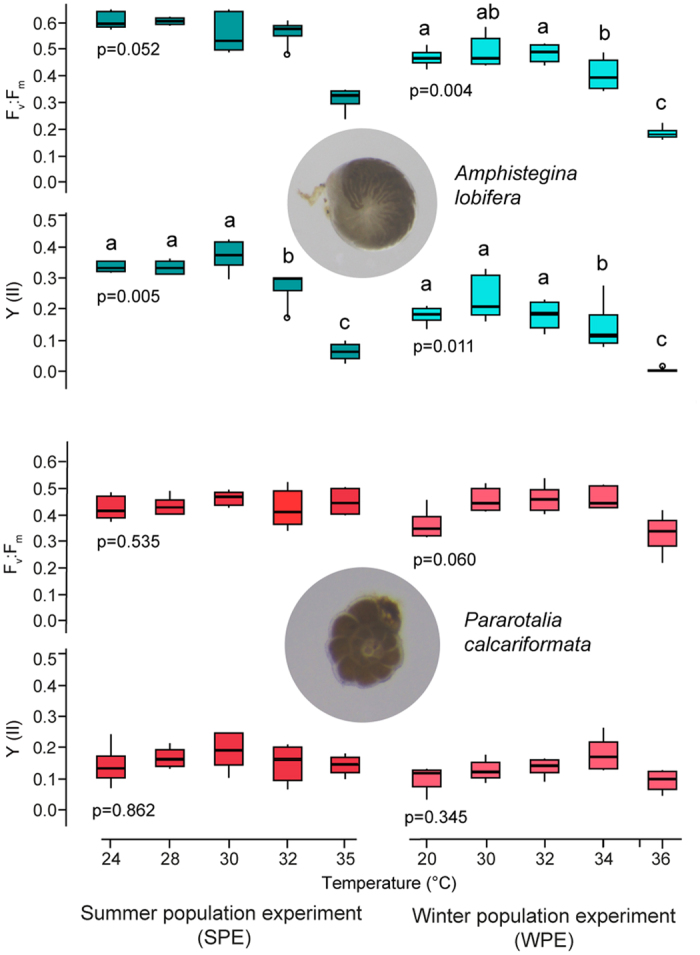
Photochemistry responses in the manipulative experiments of Amphistegina lobifera (turquois) and Pararotalia calcariformata (pink) after two weeks of exposure to experimental temperatures.Fv:Fm maximum quantum yield, Y(II) effective quantum yield measured at experimental light intensity, data plotted are shown as boxplots (the top and bottom of the box represent 1st and 3rd quartile, the 2nd quartile the median, and the lines extending from the box extent to the outermost data that fall within the distance computed as 3rd quartile ± 1.5 *interquartile range), each graph has N = 29–33 independent data points, which are given as means per well, each well contained N = 5–6 specimens, see Table S1 for statistical analysis.